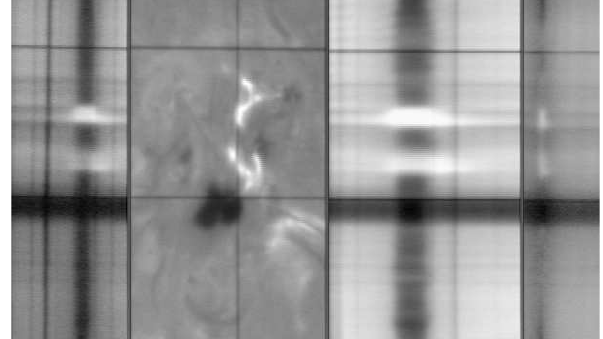
Fig. 3. The MFS composed observation of the two flare kernels at 10:01:24UT – during the second rise of the X-ray. We notice quite a substantial broadening of the H α emission profiles in the kernel.